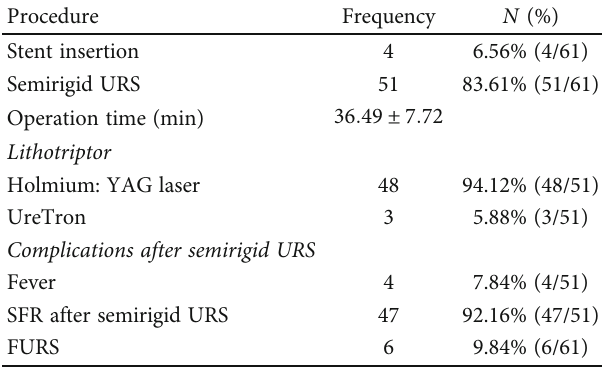
Table 2: Procedural outcomes and e ffi